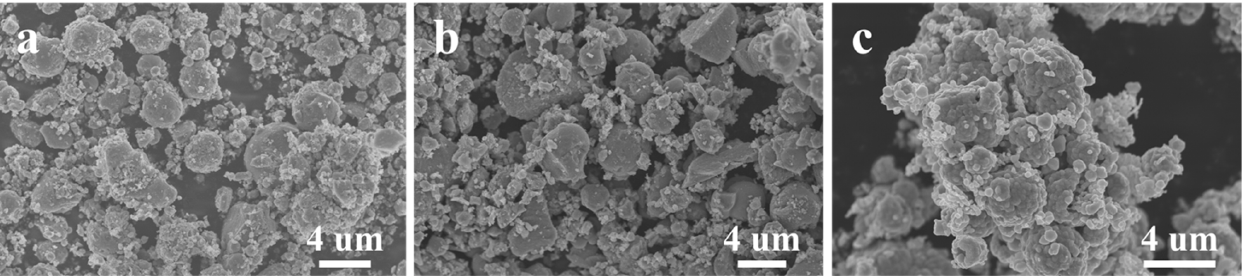
Figure 3. SEM images of ZnS obtained at different temperatures: ( a ) 90 °C, ( b ) 150 °C, ( c ) 200 °C.